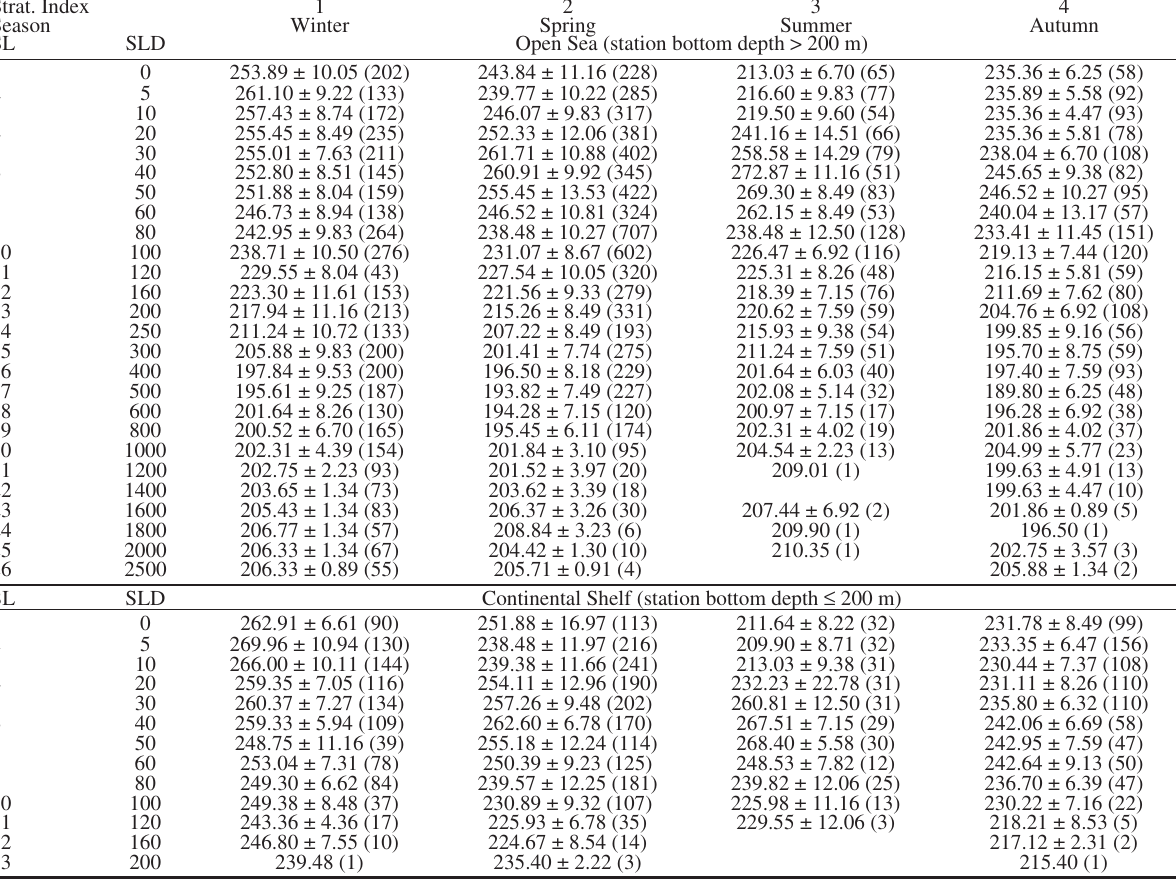
Table S8. – Dissolved oxygen concentration (μM) with depth and stratification of the water column in the Catalan Sea (NW Mediterranean Sea). Shown are median ± median absolute deviation (number of data between parentheses). SL, Standard Level; SLD, Standard Level Depth (m). Strat. Index